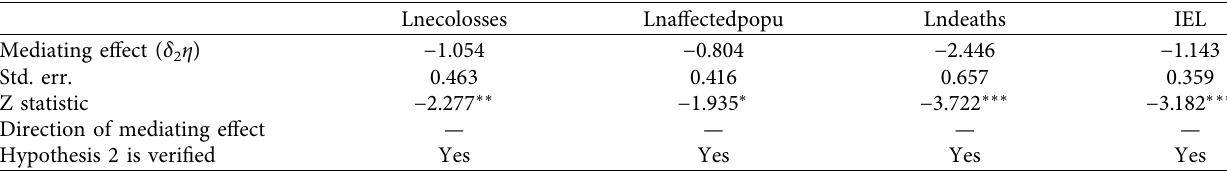
Table 9: Sobel–Goodman test results of mediating effect.